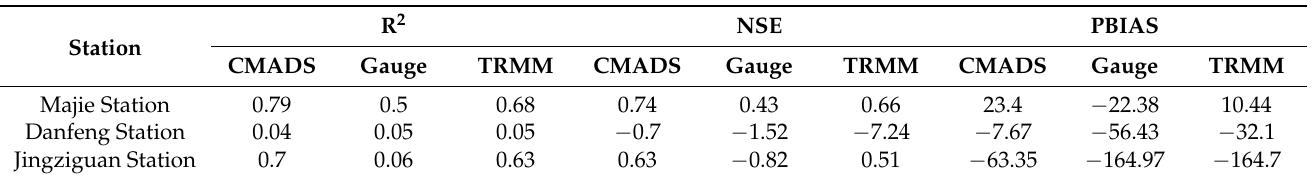
Table 4. The pre-calibration performance error amounts of the SWAT model simulated with CMADS, TRMM, and Gauge data on a monthly scale.